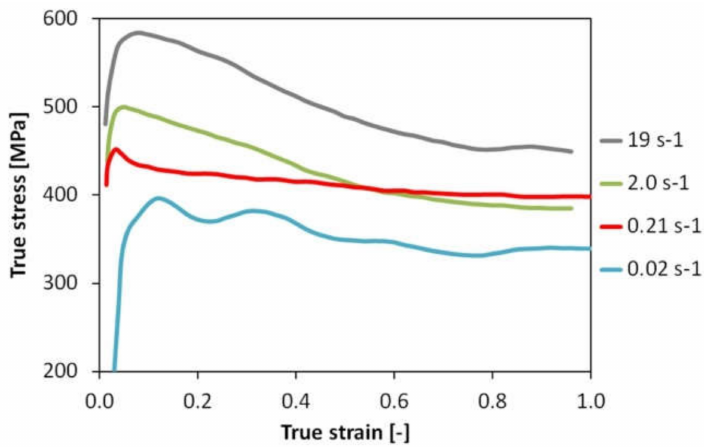
Figure 14. Influence of strain rate on flow curves at a nominal temperature of 650 ◦